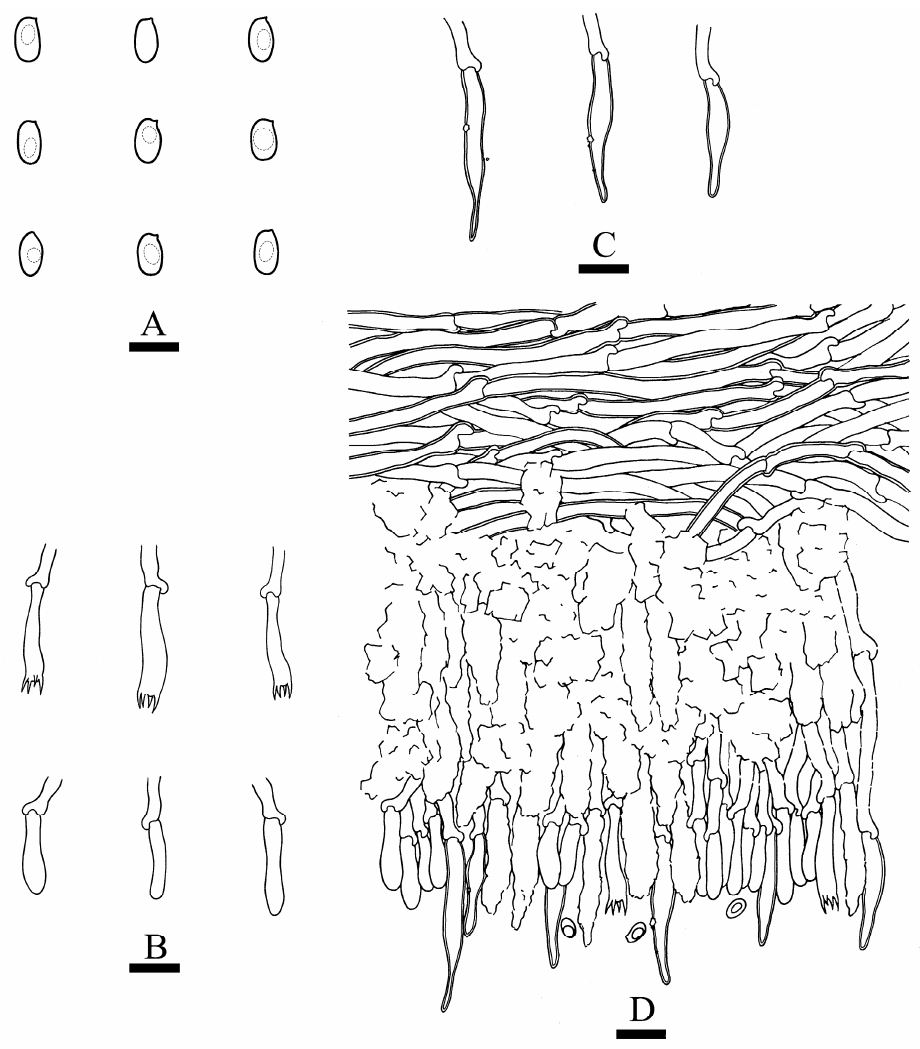
Figure 8. Microscopic structures of Luteoporia straminea (drawn from CLZhao 18947, holotype). ( A ) Basidiospores. ( B ) Basidia and basidioles. ( C ) Cystidia. ( D ) A section of hymenium. Bars: (A) = 5 µ m, ( B – D ) = 10 µ